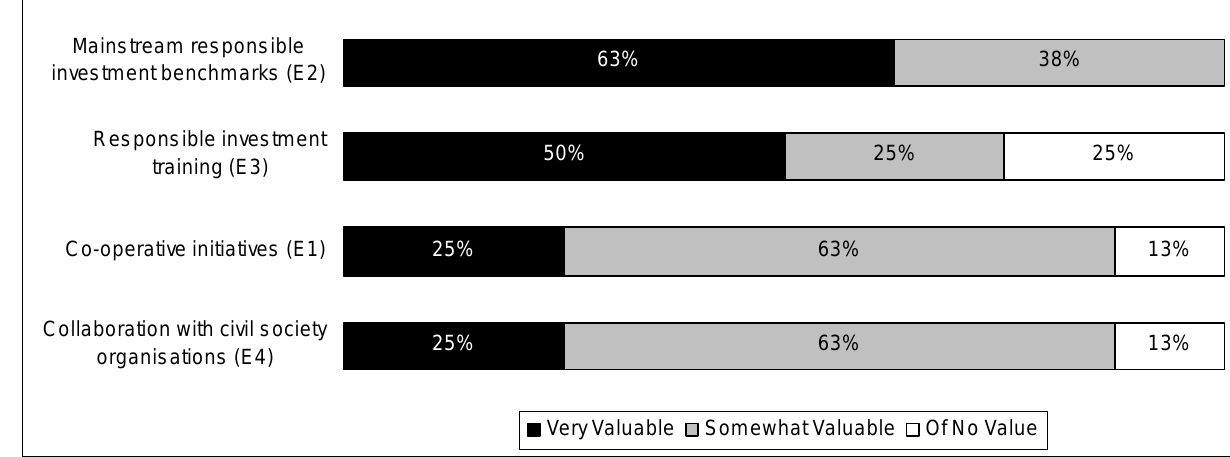
Figure 9: Advisory service providers - RI